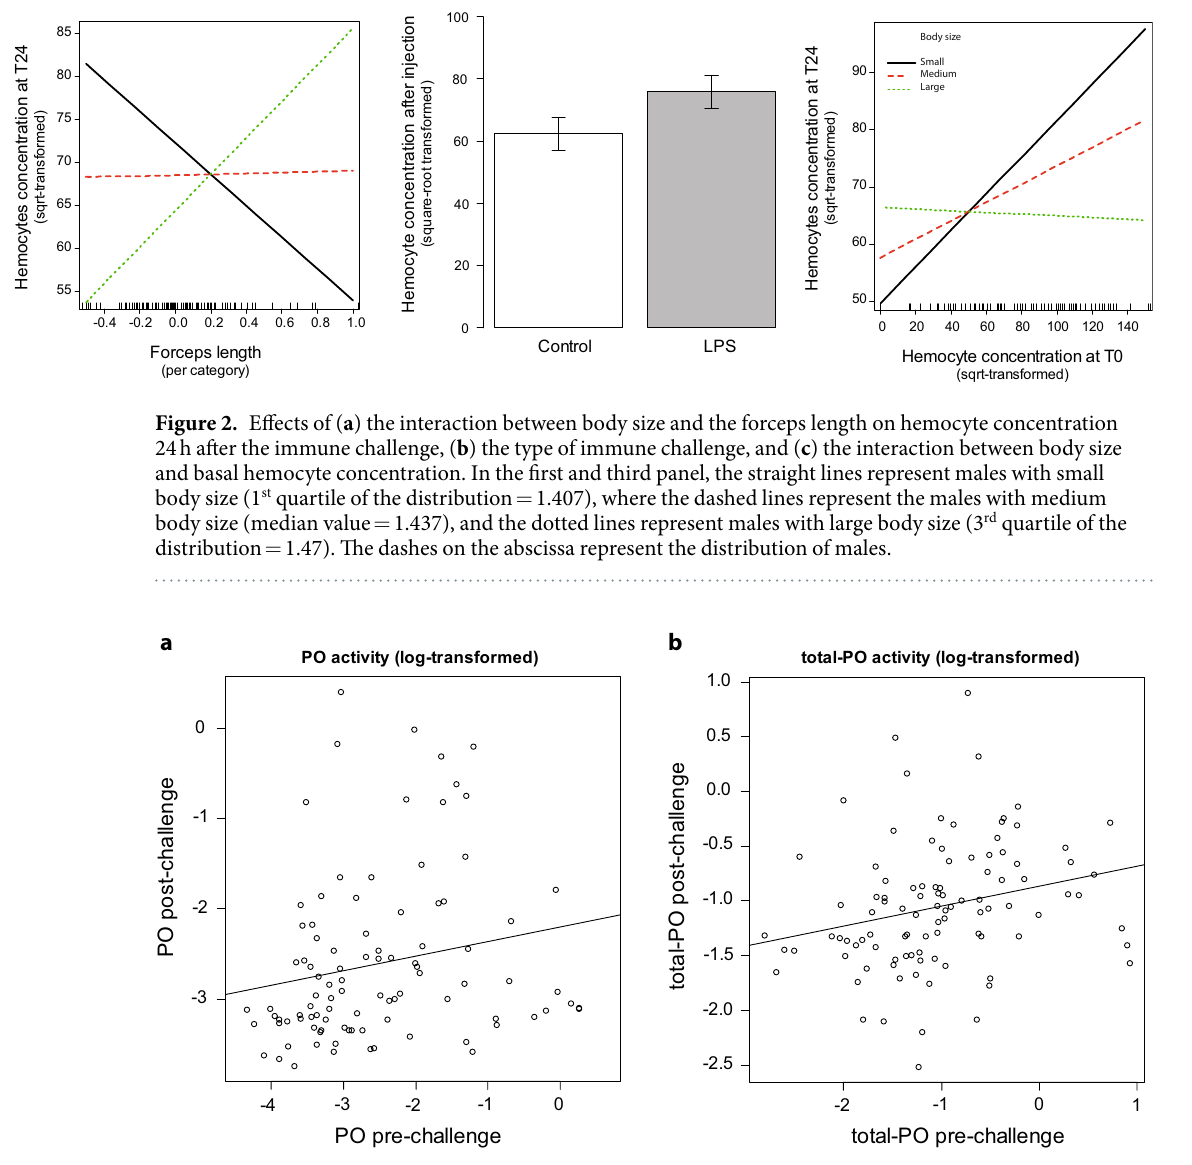
Figure 3. Association between the measurements of ( a ) PO and ( b ) total-PO activities before and after the immune challenge.